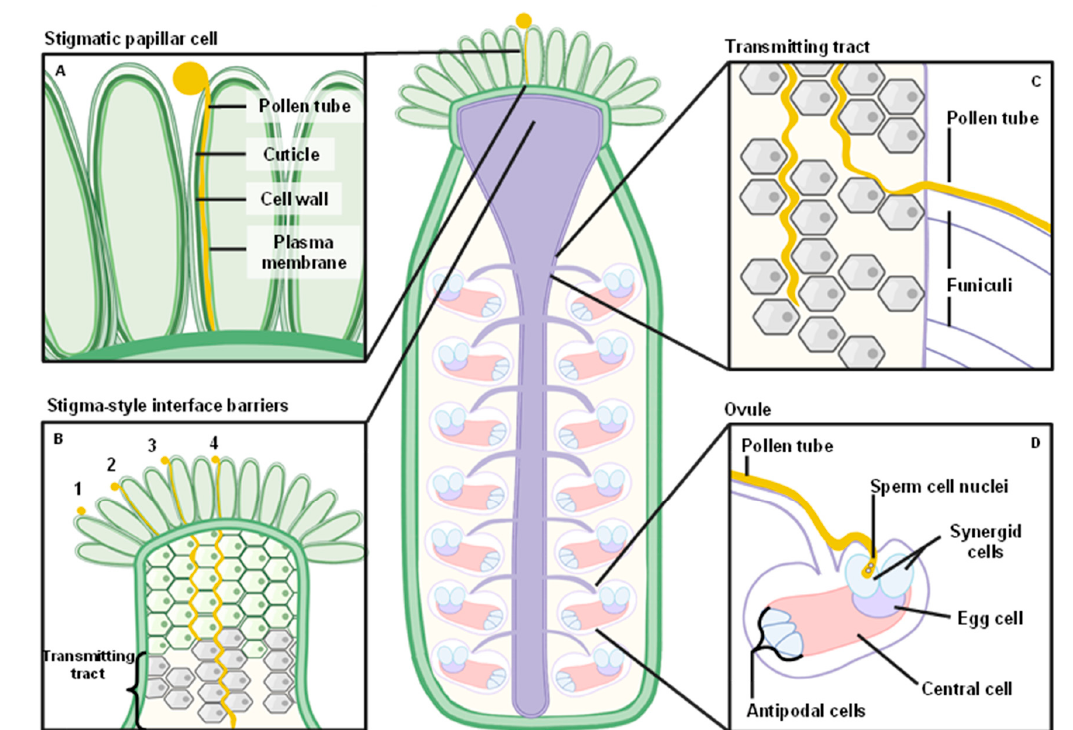
Figure 1. Schematics of physical barriers encountered by the pollen tube. An Arabidopsis pistil is shown with various physical barriers that are encountered by the pollen tube. ( A ) Pollen grain foot formation, hydration and subsequent pollen tube germination occurs at the stigmatic papillae, and pollen tube growth occurs between the cell wall and plasma membrane layers. ( B ) Possible barriers encountered by the pollen tube are displayed including penetration of (1) the stigmatic papillae, (2) the stigma-style interface, and (3) the transmitting tract. The fourth pollen tube has successfully penetrated through these barriers and is descending through the transmitting tract. ( C ) Germinating pollen tubes navigating the transmitting tract receive guidance cues that prompt pollen tubes to exit the transmitting tract tissues and begin moving along a funiculus to reach the ovule . ( D ) The ovule is penetrated by the pollen tube via the micropylar opening. The pollen tube then penetrates the degenerating synergid cell. Subsequent bursting and delivery of the sperm cell nuclei are imminent.